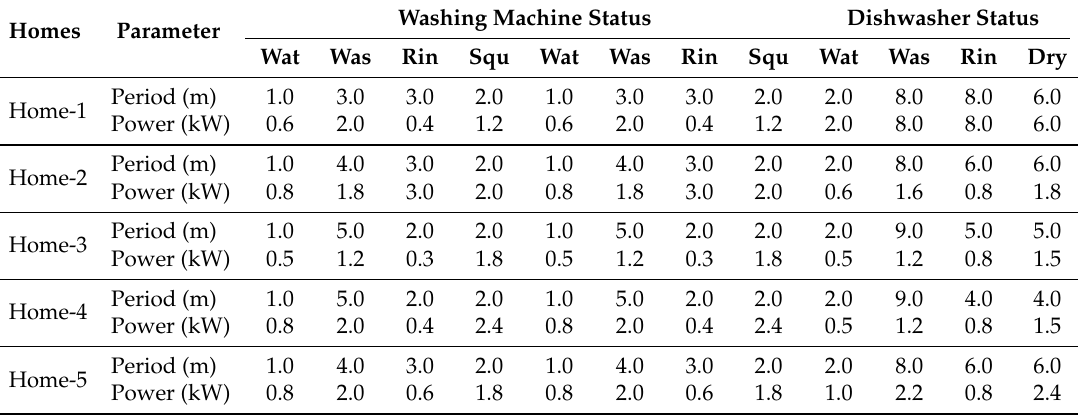
Table 2. Washing machine and Diswasher operation parameters.